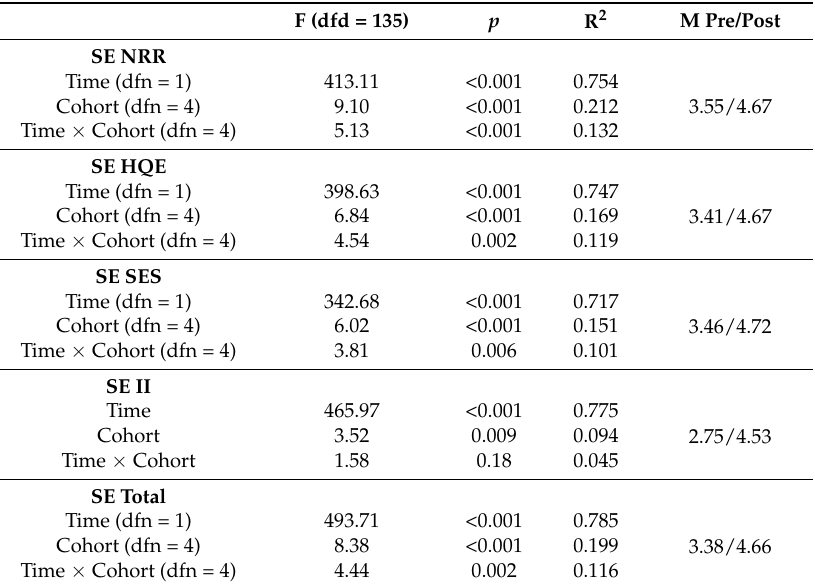
Table 3. The Effects of Time, Cohort, and Time × Cohort on